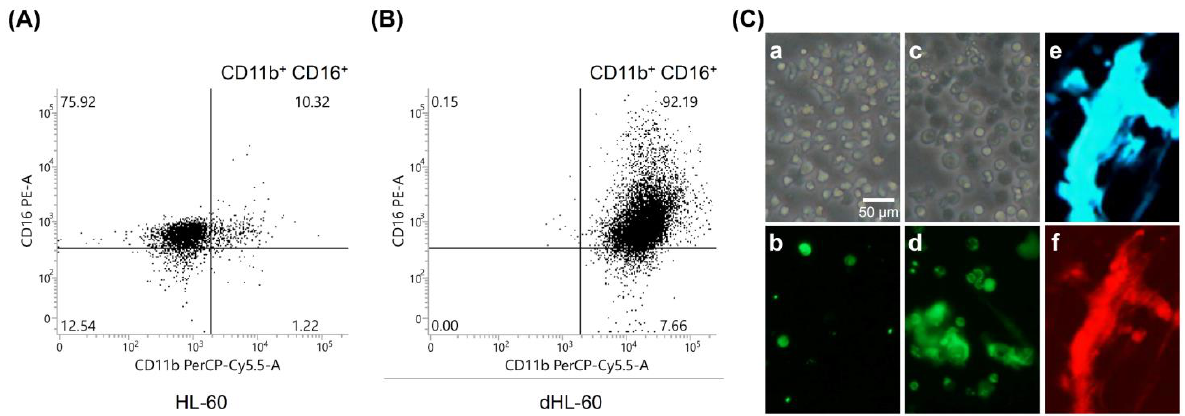
Figure 2. The induction of human promyelocytic leukemia cells (HL-60) into mature granulocytes (dHL-60) by all-trans retinoic acid (ATRA), and the PMA-stimulated NET formation by dHL-60 cells. ( A ) The expression of CD11b + CD16 + surface markers on undifferentiated HL-60 cells detected by two-color flow cytometry. Only 10.32% cells are double positive. ( B ) The expression of CD11b + CD16 + surface markers on ATRA-induced dHL-60 cells. After ATRA induction, 92.19% of dHL-60 express both CD11b and CD16 granulocyte differentiation markers on the cell surface. ( C ) A representative case showing NET formation in PMA-activated dHL-60. ( a ) Light microscopic observation of dHL-60. ( b ) SYTOX green nucleic acid stain of non-stimulated dHL-60 cells observed by fluorescent microscope. ( c ) Light microscopic observation of 4 h PMA-stimulated dHL-60. ( d ) SYTOX green nucleic acid stain of 4 h PMA-stimulated dHL-60 observed by fluorescent microscope. ( e ) NET formation of PMA-stimulated dHL-60 identified by DAPI stain. ( f ) NET formation of PMA-stimulated dHL-60 identified by Alexa Fluor 594-labeled anti-citrullinated histone H3 antibody stain. Scale bar: 50 μm.